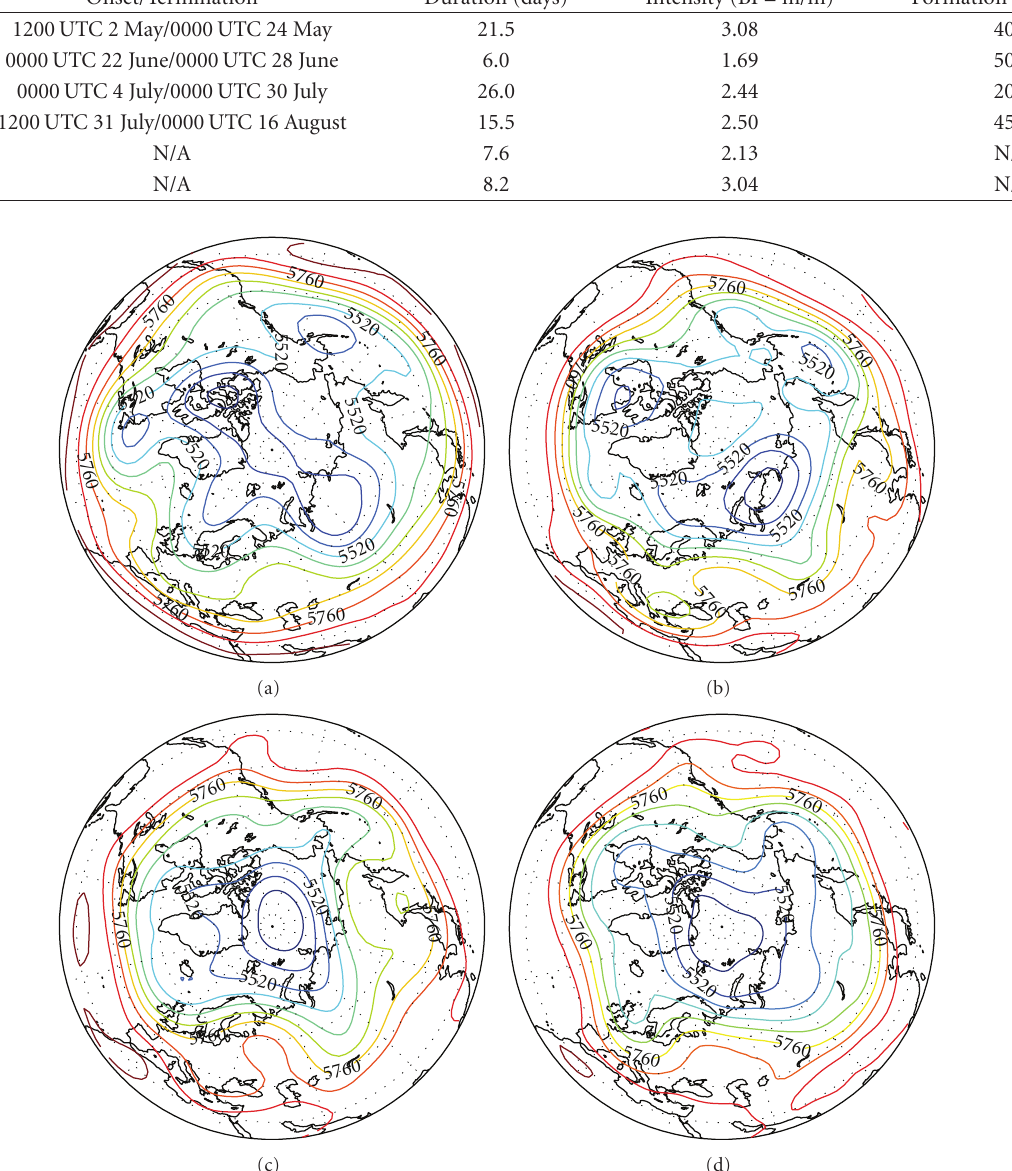
Figure 1: The NCEP-NCAR reanalyses for the Northern Hemisphere 500 hPa heights for (a) May, (b) June (20–30), (c) July, and (d) August (1–20), 2010. The contour interval is